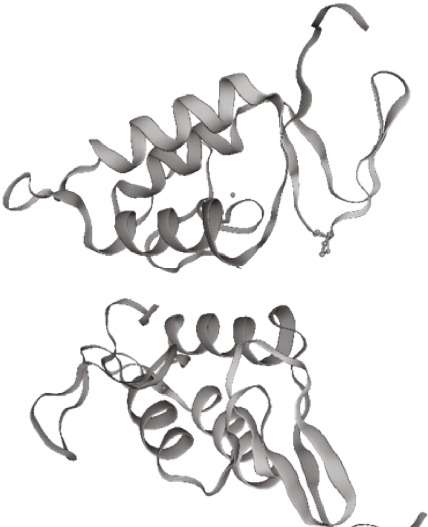
Figure 6: 3D structure of PLA web server. Predicted 3D structure of Maurolipin with 38.83% identity to bee venom PLA